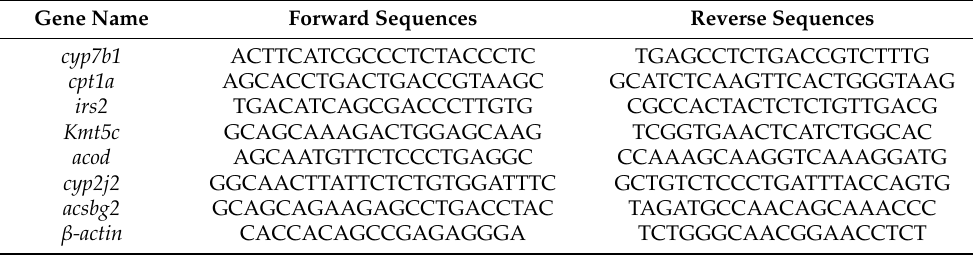
Table 2. Sequences of primers used in this study.